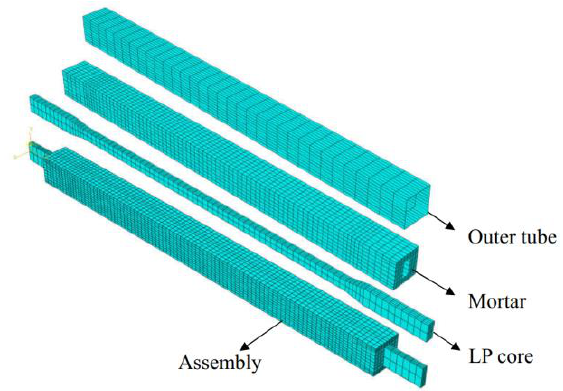
Figure 5. Finite element model of LPBRB specimen.